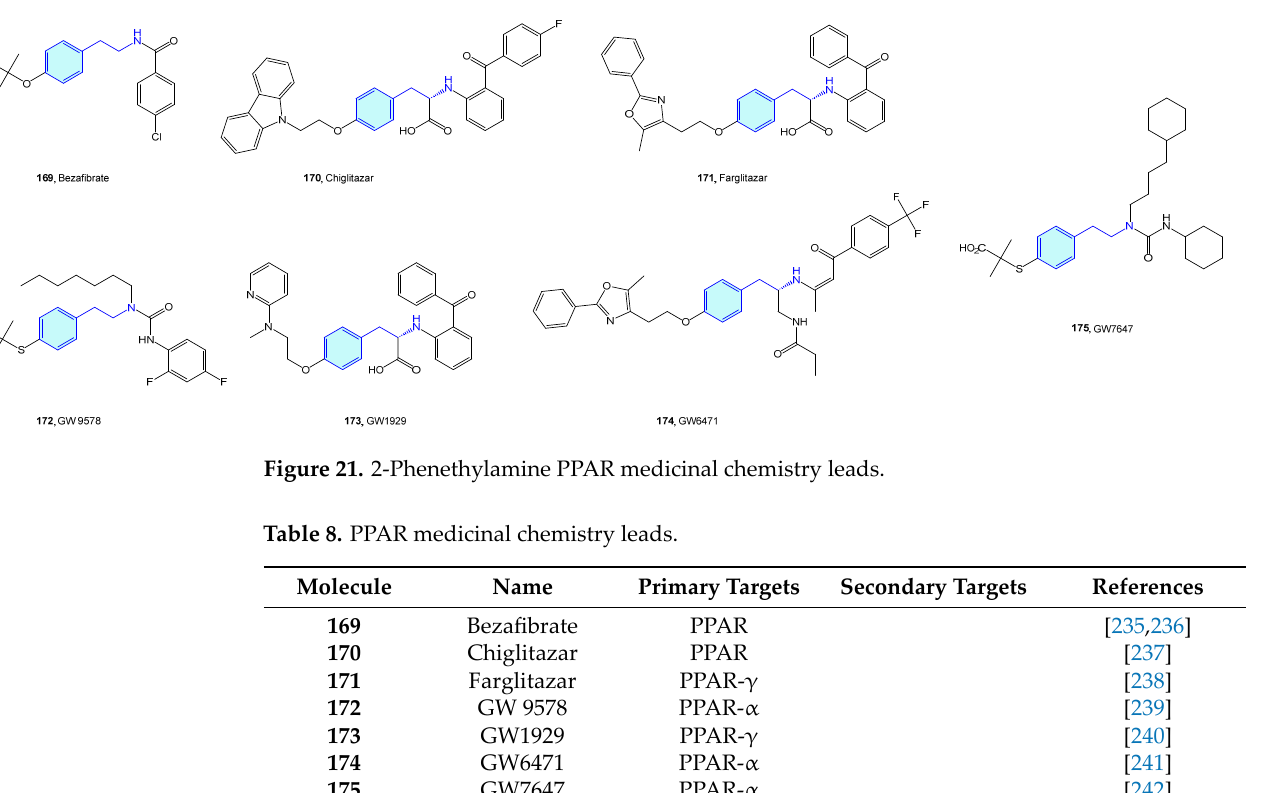
Figure 21 . 2-Phenethylamine PPAR medicinal chemistry leads.